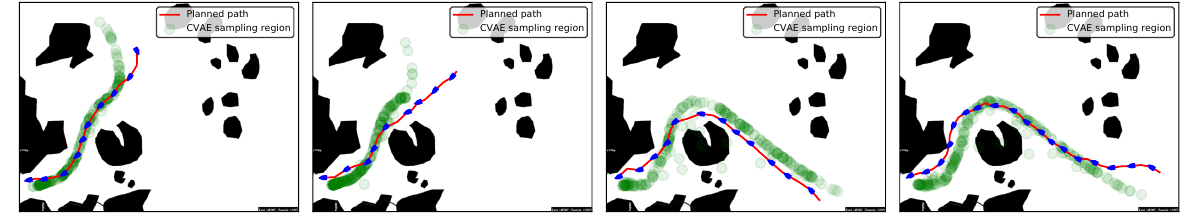
Figure 4: Examples of the path using RRT* with a learned CVAE sampler in the Mausund harbor.